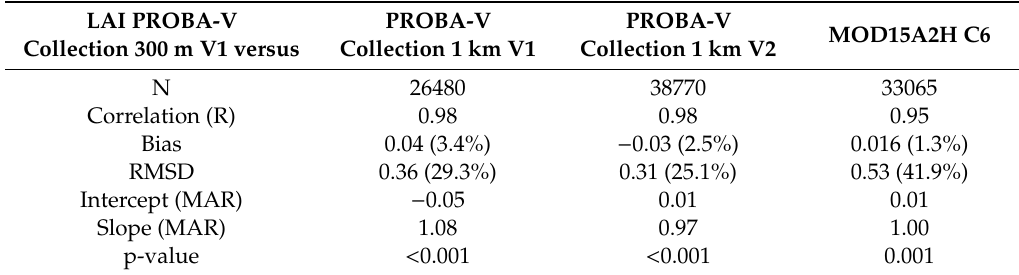
Table 7. LAI PROBA-V Collection 300 m V1 versus reference validation metrics computed over all LANDVAL sites for the 2016–2017 period. Relative values (%) are shown in